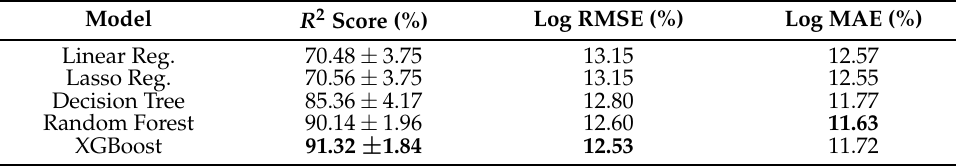
Table 7. Performance of classifiers on test